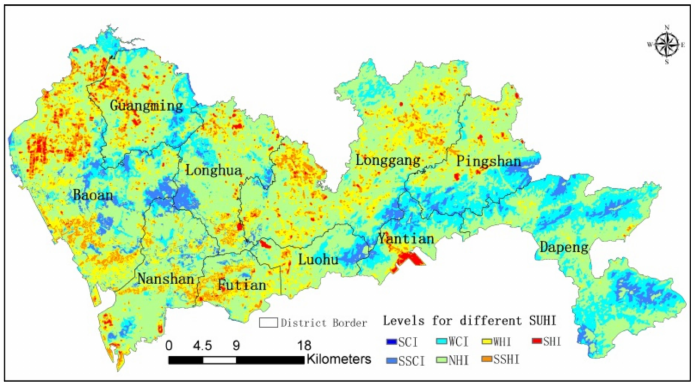
Figure 8. SUHI grades on 22 July